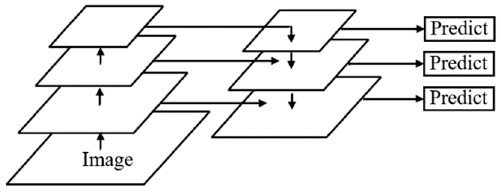
Figure 1. The structure of FPN.